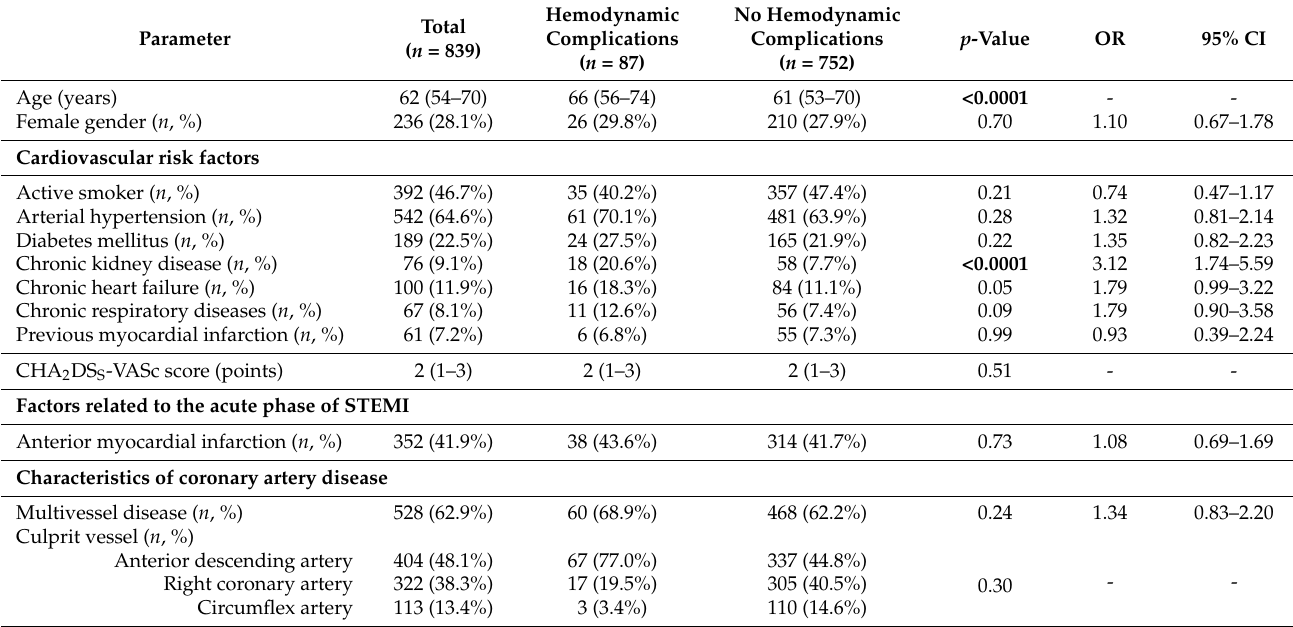
Table 3. Characteristics of patients with and without ST-segment elevation myocardial-infarction- related hemodynamic complications.